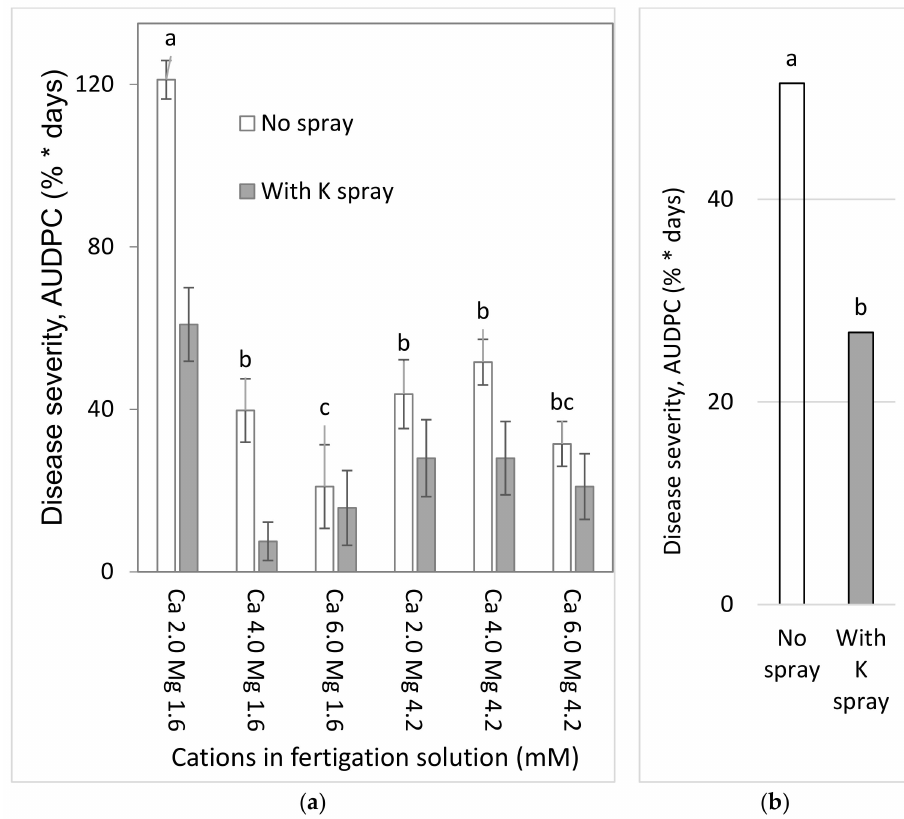
Figure 7. Effects of fertigation with three Ca concentrations (2.0–6.0 mM) applied in combination with two concentrations of Mg (1.6–4.2 mM), without ( (cid:3) ) and with ( (cid:4) ) a foliar spray of 1% K 2 SO 4 , on the severity of sweet basil downy mildew (SBDM). SBDM severity was evaluated on a 0–100% scale, in which 0 = healthy plants and 100% = plants completely covered by SBDM symptoms/signs. The area under disease progress curve (AUDPC) over 86 days was calculated. ANOVA revealed a significant interaction between the Ca and Mg fertigation treatments, and it revealed no interaction between the treatments of no spray and K spray. Therefore, Ca and Mg fertigation treatments are described as single treatment ( a ). The foliar K treatments were analyzed as major treatments over all of the irrigation treatments ( b ). Values in each graph that are labelled with a common letter are significantly not different according to ANOVA with Tukey’s HSD. Default significance levels were set at α = 0.05. Bar =